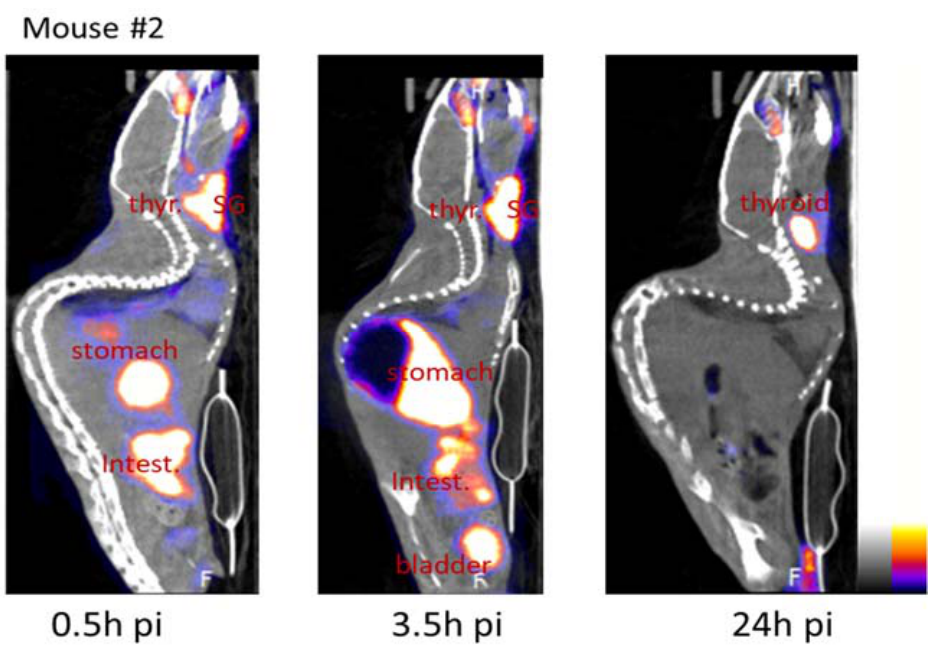
Figure 5. Examples of images collected from an infected mouse (sagittal view). Radioactivity was high in iodine-targeted tissues (stomach, intestine, salivary glands (SG)) and radiotracer entrance